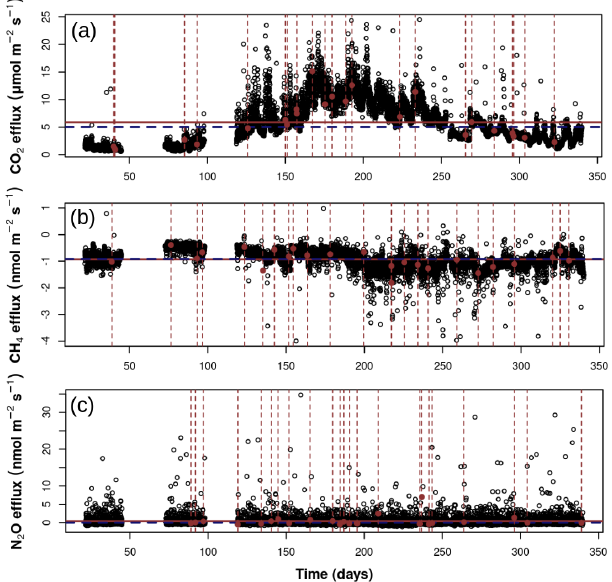
Figure 2. Time series of automated measurements ( F A ) of soil greenhouse gas fluxes (black circles) and optimized samples ( k = 24) using a temporal univariate Latin hypercube sampling (tuLHs) approach for soil CO 2 (a) , soil CH 4 (b) , and soil N 2 O (c) fluxes. The horizontal red line represents the mean, and the horizon- tal blue line is the median of each greenhouse gas flux derived from automated measurements. The selection of data points for k = 12 and 48 is presented for each soil greenhouse gas time series in Figs. S3 and S4, respectively. Time ( x axis) represents days from 1 January to 31 December